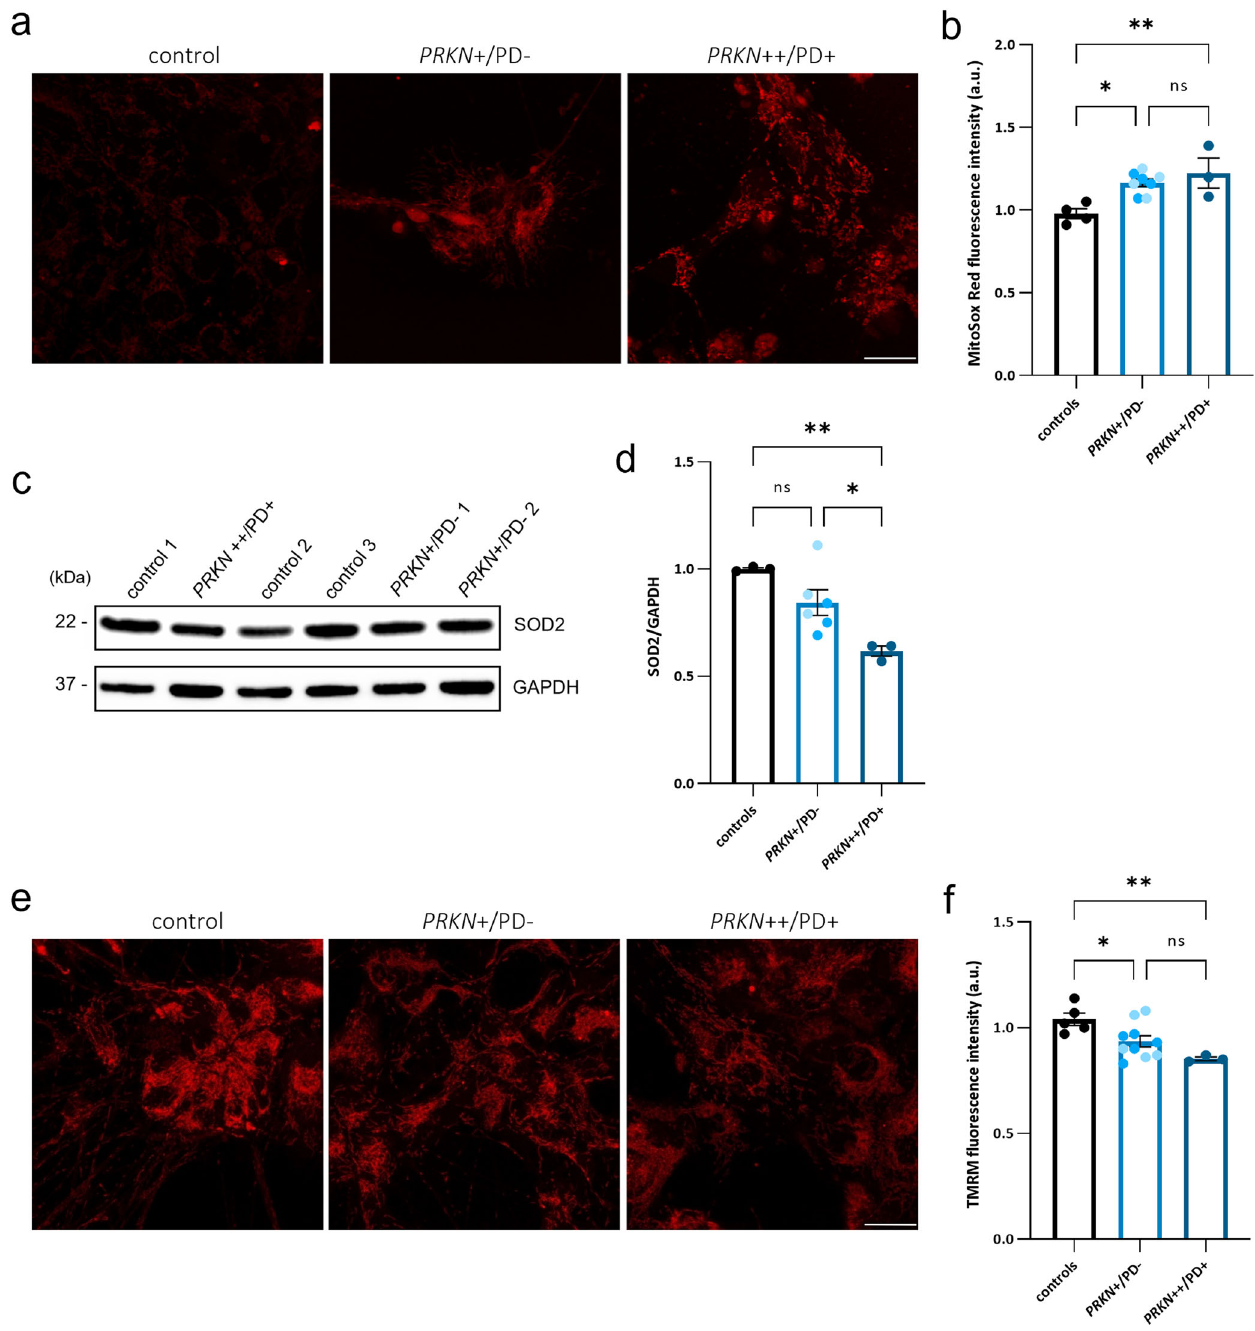
reduced for the homozygous PRKN -PD line (1.26 ± 0.15 vs. 0.70 ± 0.17; p = 0.026) but also for the heterozygous PRKN variant lines (1.26 ± 0.15 vs. 0.83 ± 0.15; p = 0.049) (Fig. 3e). The decrease in was not signi fi cant ( p = 0.57, p = 0.65, respectively). carrying a heterozygous variant in PRKN , we measured mitochondrial